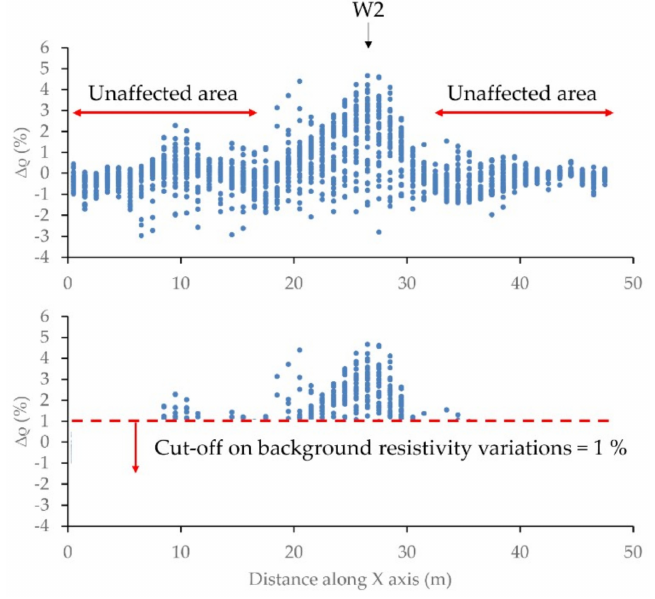
Figure 6. Filtering scheme and the + 1% cut-o ff value on ∆ ρ i